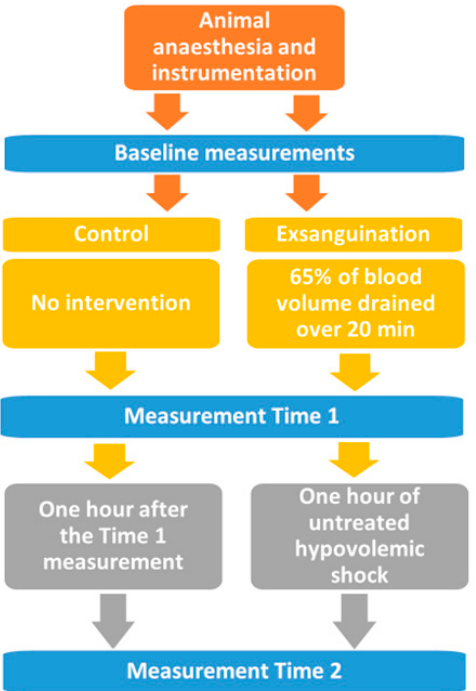
Figure 1. Summary of the study design and the timing of measurements taken. Measurement Time 1: Immediately after 65% blood loss in the experimental group, and simultaneous blood sampling in the control group; Measurement Time 2: One hour after 65% blood loss in the experimental group, and simultaneous blood sampling in the control group.